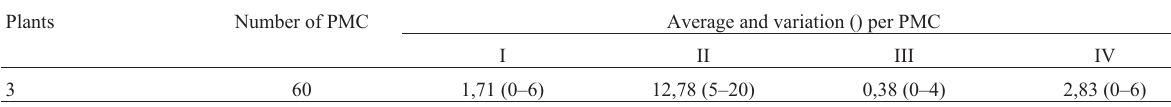
Table 2 - Chromosome configurations found in male meiocytes of tetraploid Paspalum modestum. Plants Number of